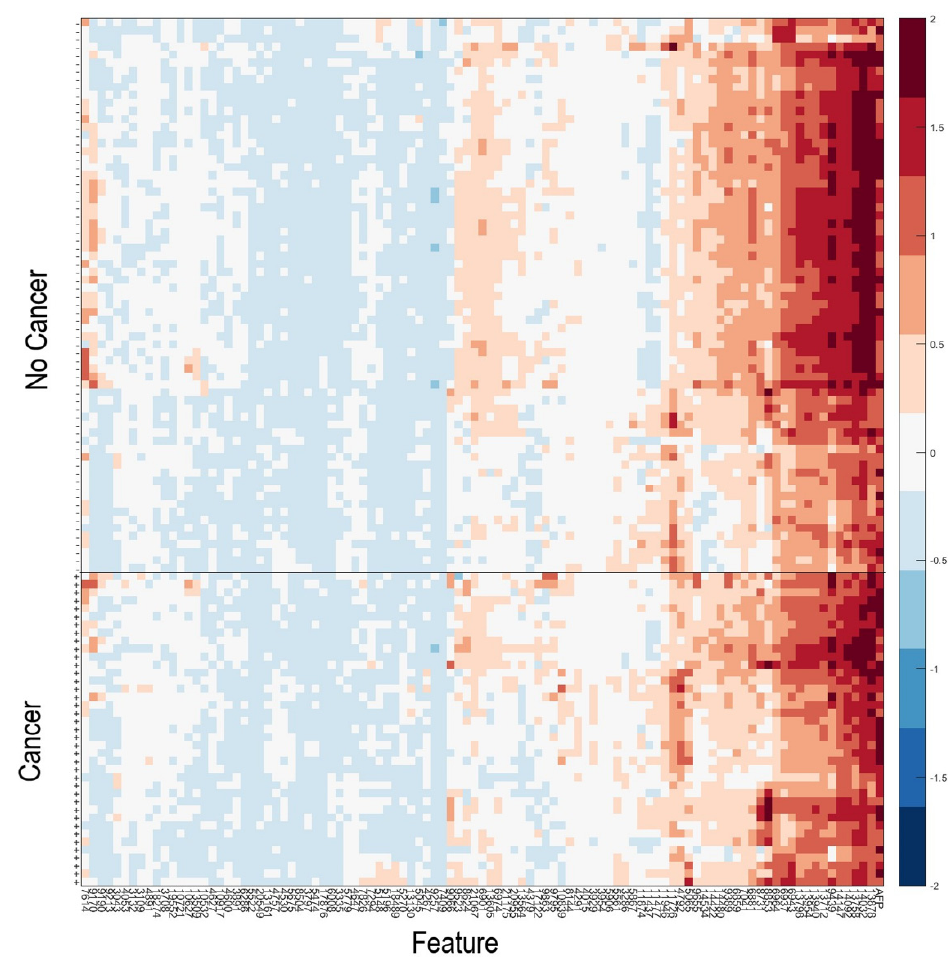
Figure 2. Heatmap of the natural logarithm of serum AFP and the MS features used for classification for the 108 samples used in classifier development. + indicates samples from patients with HCC; - indicates samples from patients without HCC. Features and samples are hierarchically clustered.